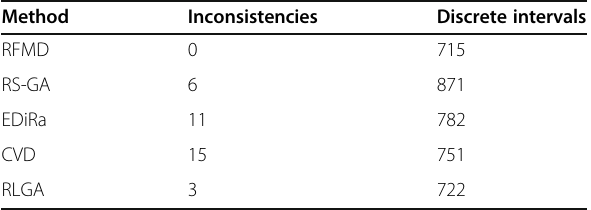
Table 10 Number of data errors in the banknote authentication dataset